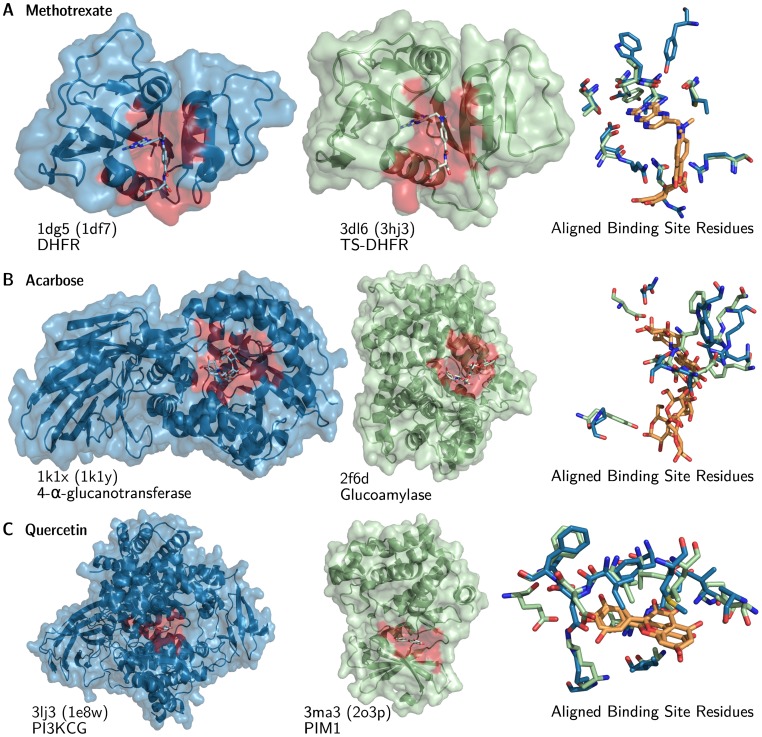
Structural details of binding site similar targets.The binding site alignments for the targets of (A) methotrexate, (B) acarbose and (C) quercetin (highlighted in blue in Figure 7) are visualized. Binding sites are highlighted in red and ligands are displayed in orange. PDB IDs are given below the structures. If the given ID is a representative of a cluster, the PDB ID of the underlying structures is given in parentheses.